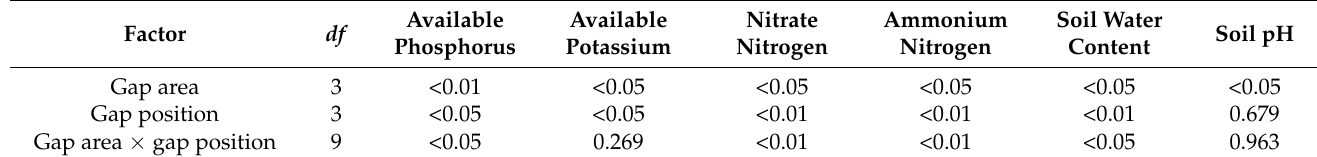
Table 5. Two-way analysis of variance (ANOVA) for the effects of gap size and location on soil basic chemical properties in evergreen broad-leaved secondary forest.